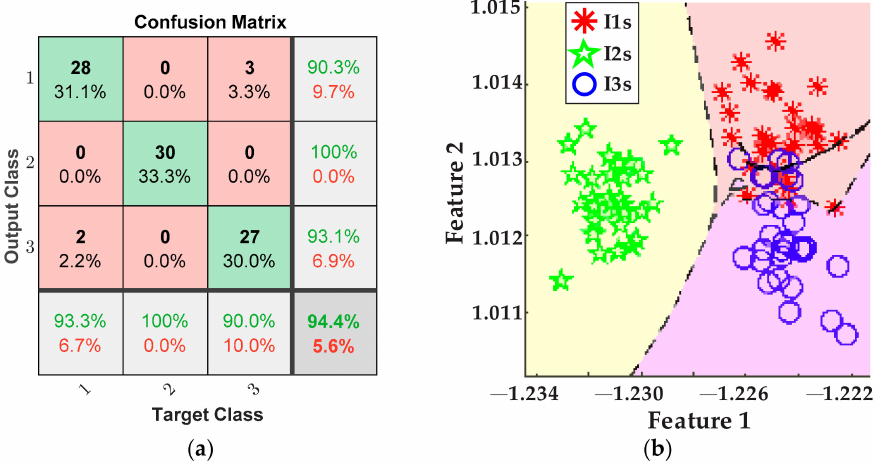
Figure 11. Results from cutting speed variations for the fusion of AC current and stray flux sensors; ( a ) confusion matrix and ( b ) ANN